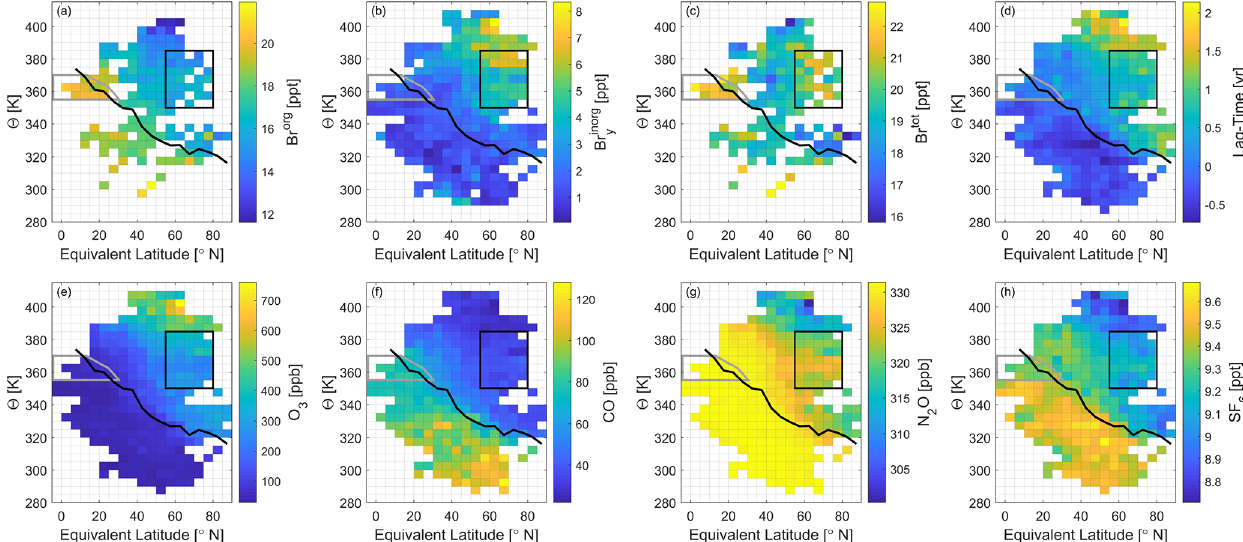
Figure 5. The WISE campaign in fall 2017 as a function of equivalent latitude and potential temperature for (a) Br org mixing ratios (CH 3 Br + halons + VSLS) from GhOST-MS, (b) Br inorg y VMR from mini-DOAS BrO scaled by the CLaMS BrO / Br inorg y ratio, (c) Br tot VMR, (d) mean air mass lag time (based on SF 6 data from GhOST-ECD), (e) O 3 VMR from FAIRO, (f) CO VMR from UMAQS, (g) N 2 O VMR from UMAQS, and (h) SF 6 VMR from GhOST-ECD. The data are binned in 5 ◦ grids of equivalent latitude and 5K grid potential temperatures. The solid thick black line is the mean WMO TP over the campaign duration. The black box in the LMS from 55 − 80 ◦ N and 350 − 385K is the high bromine region (HBrR), and the gray outline at (cid:50) > 355K and PV < 2PVU marks the tropical (cid:50) high –PV low region (discussed in the